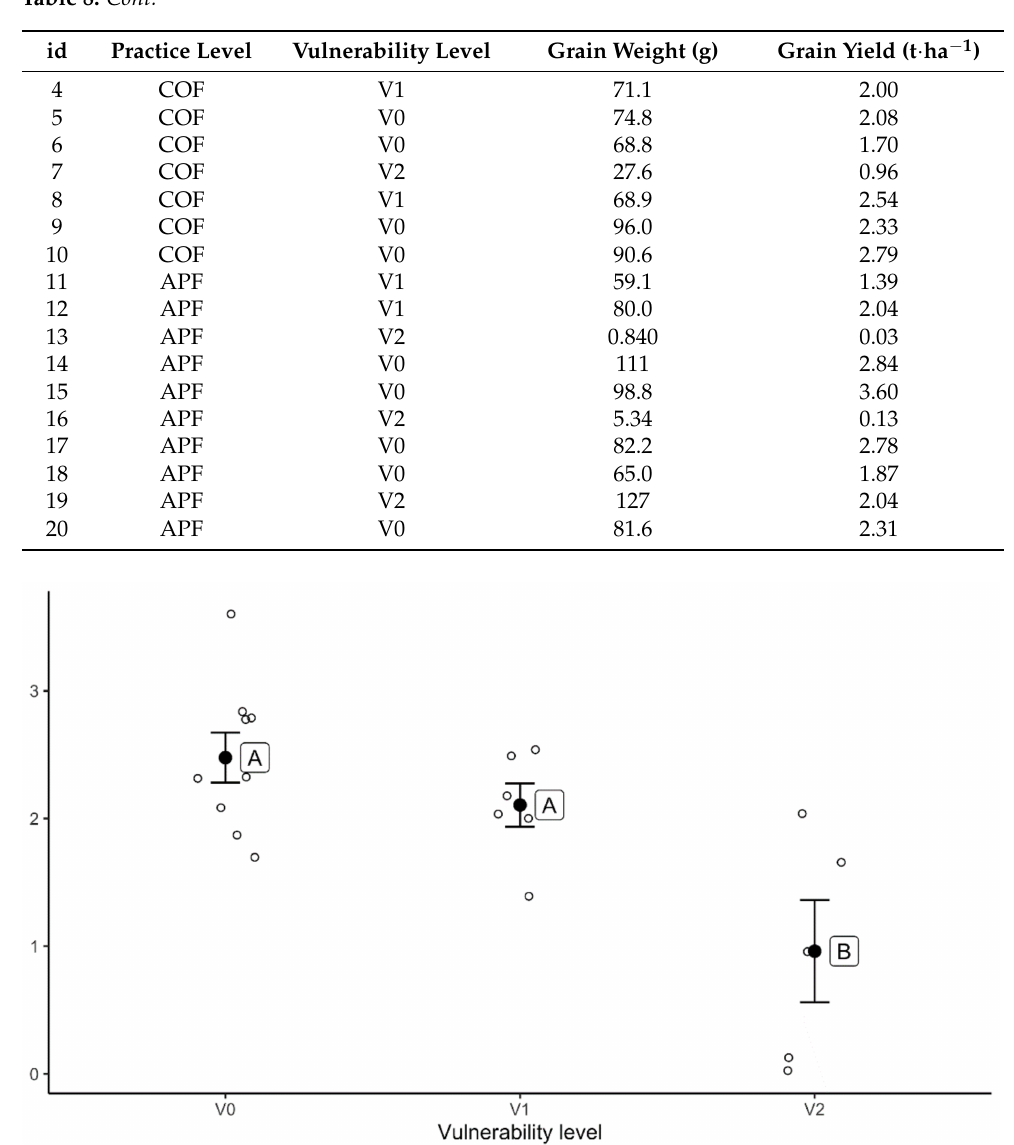
Figure 9. Grain yield in t · ha − 1 estimated on sample points (white circle) at the three different levels of vulnerability to flooding (V0: no vulnerability, V1: mildly vulnerable, V2: extremely vulnerable). Different capital letter near the bar (mean ± SD) indicate significant difference at the level of p ≤